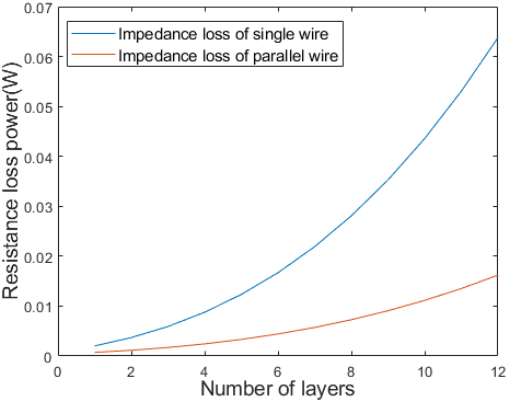
Figure 5. Power loss of different coil forms.